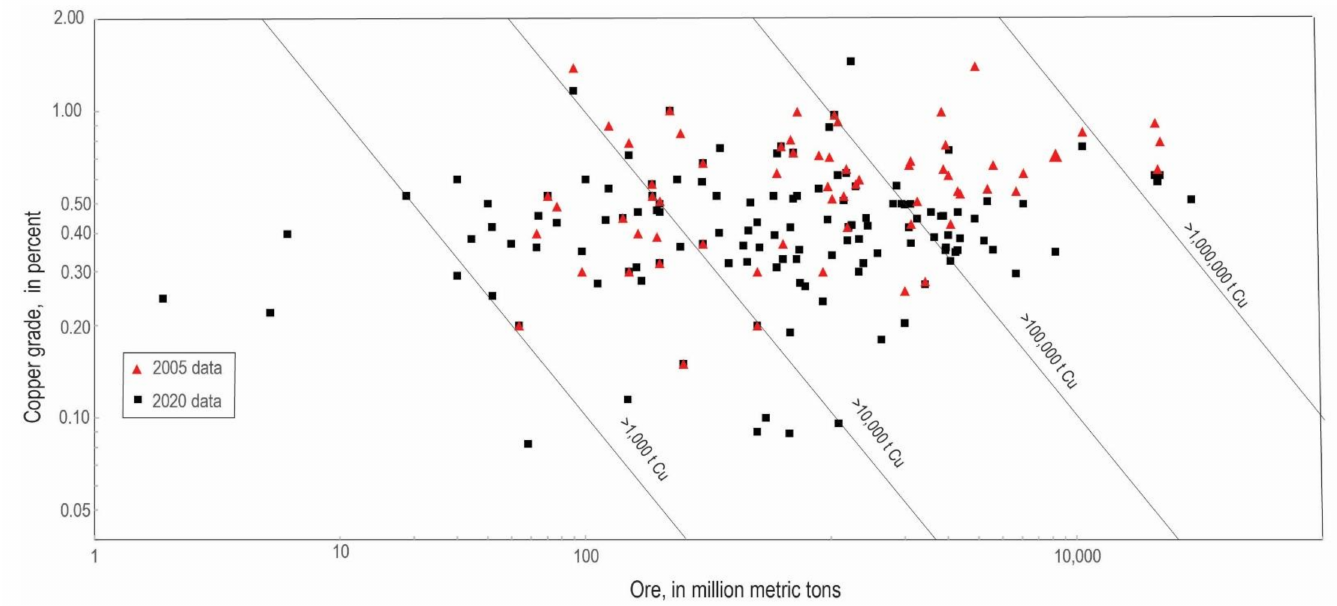
Figure 3. Scatter plot of average copper grade versus ore tonnage for porphyry copper deposits known in the Andes in 2005 and